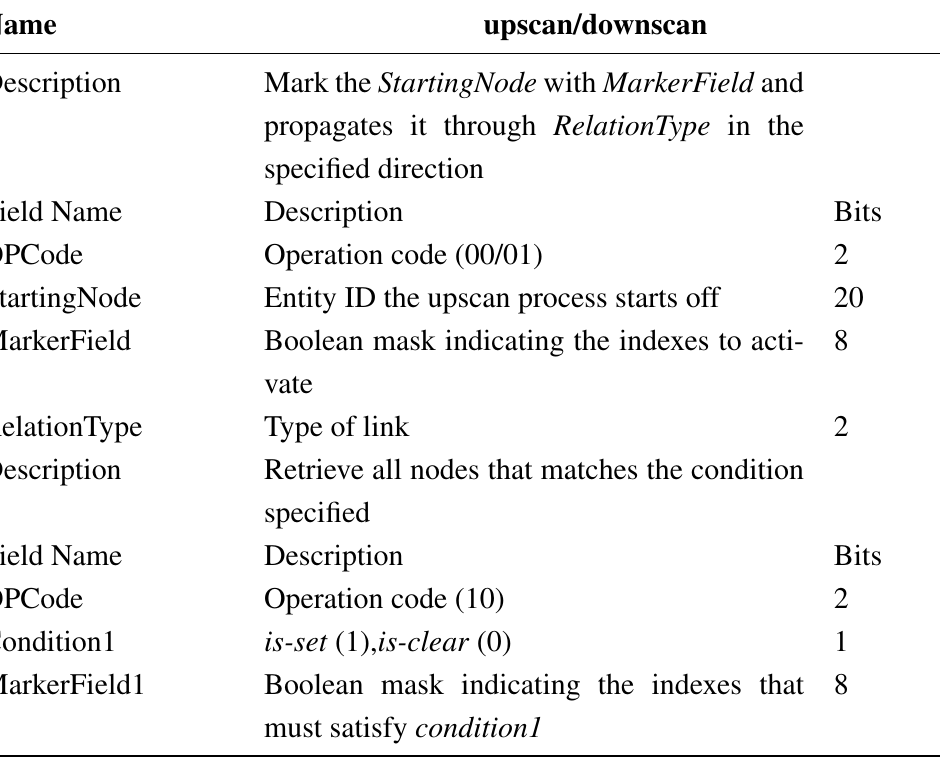
Table 2. Supported commands by the Reasoning Hardware